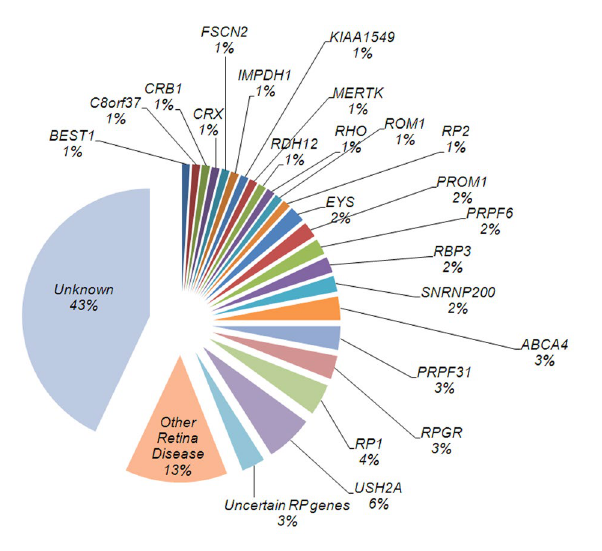
Figure 1. Mutation proportions of individual genes in the 98 small RP families. Mutation proportions of individual genes in the 98 small RP families were shown. The proportion of uncertain genes (with conserved amino acid prediction results and with low frequencies, Table 2), other retinal genes (mutations in other retinopathy genes, Table 3) and unknown genes were also